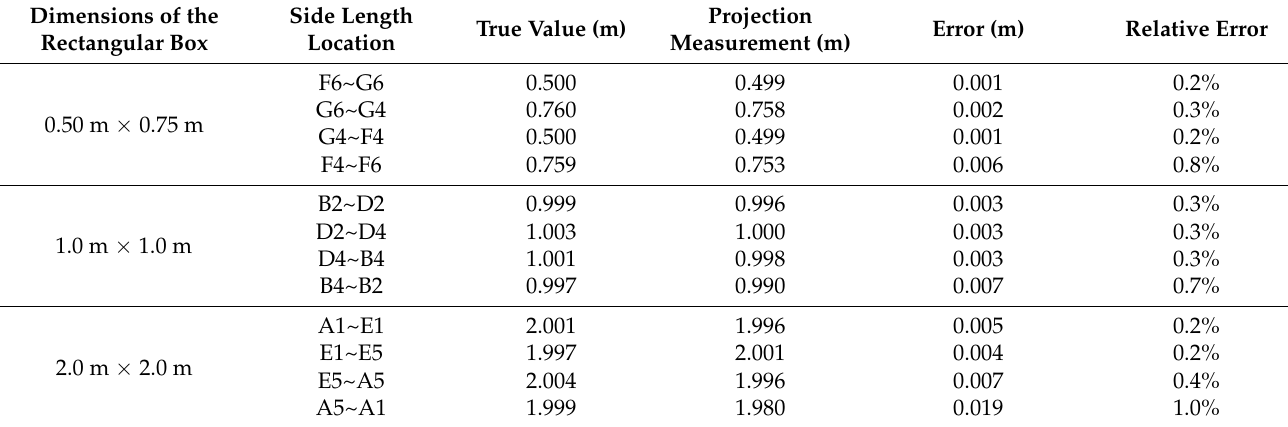
Table 4. Error analyses for different dimensions of the rectangular